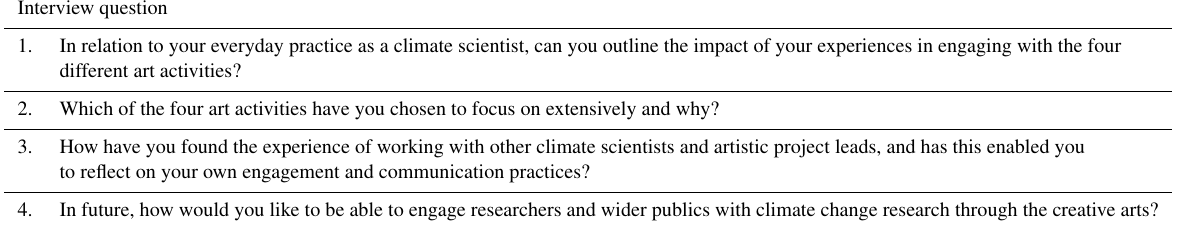
Table 3. Questions used in the semi-structured interviews with participants in Climate Stories. Interview